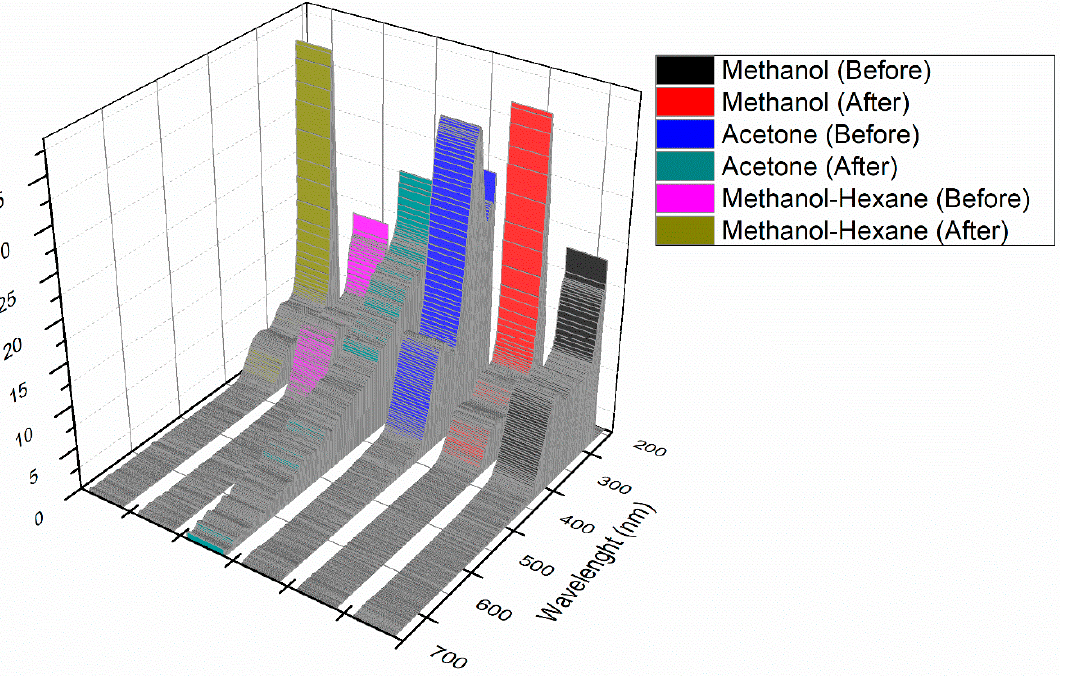
Figure 1. Absorption spectra of extracts before and after synthesis.